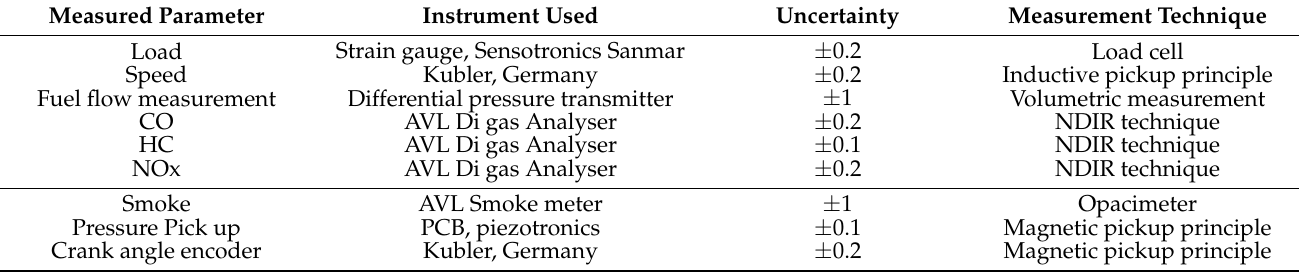
Table 3. List of instruments used along with their percentage uncertainty